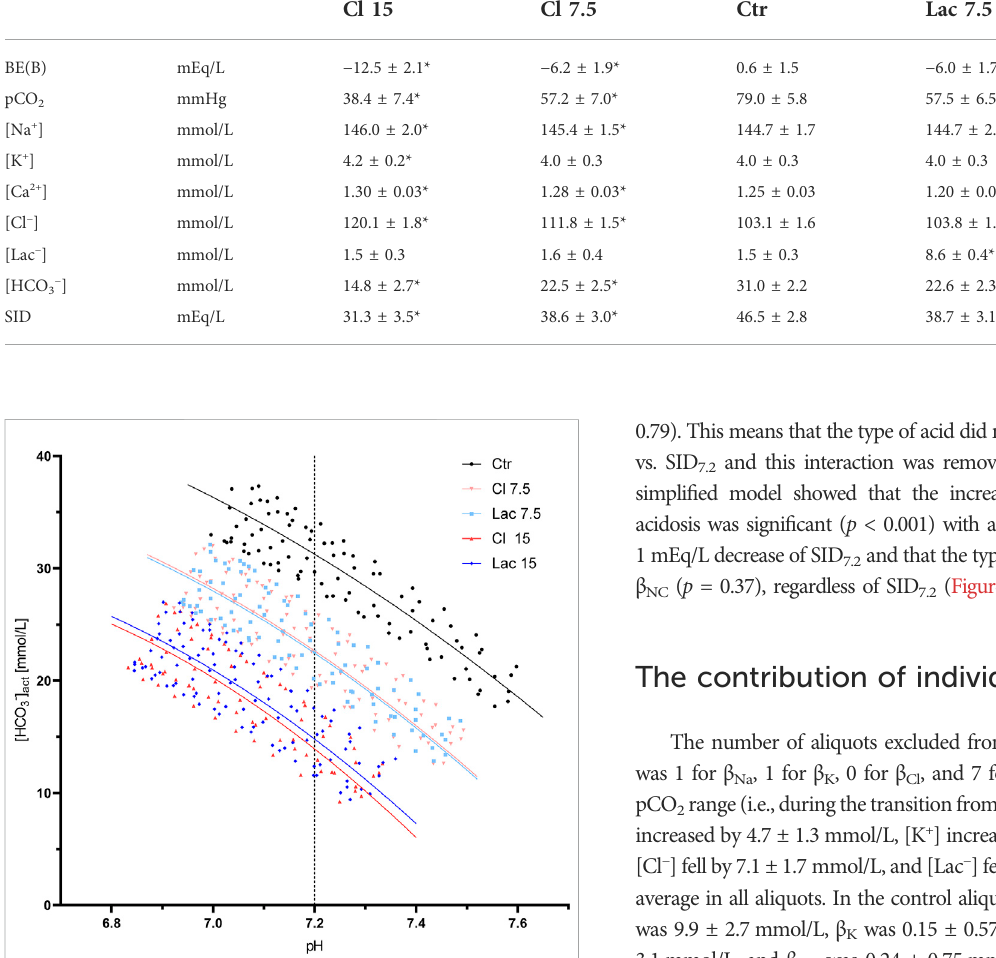
FIGURE 1 All valid pH/[HCO 3 − ] data points obtained during the CO 2 tonometry of the aliquots treated with the different stock solutions. Best- fi t quadratic regression curve is shown for each group of aliquots. The pH of 7.2, at which β NC was calculated, is marked by a dashed